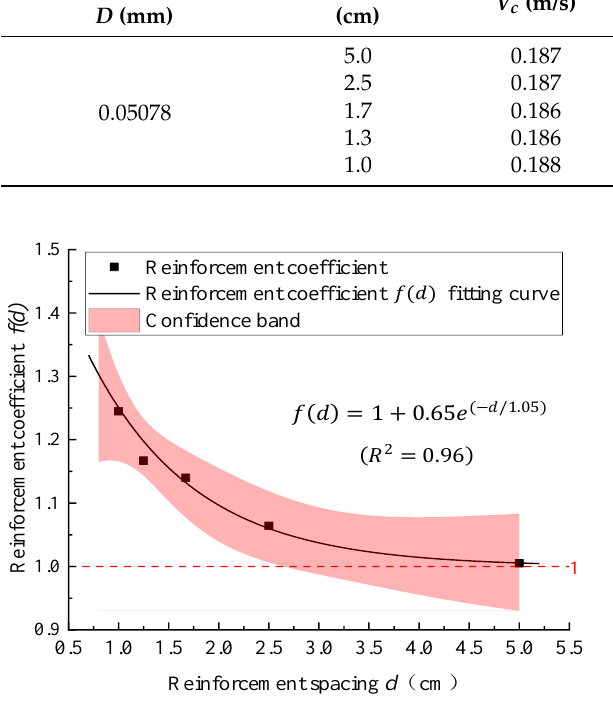
Figure 11. The fitting curve of the reinforcement coefficient f ( d ).